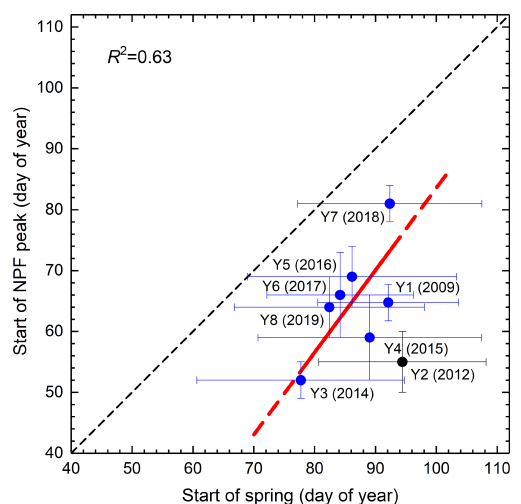
Figure 7. Scatter plot of the starting date of spring considering all vegetation and the start of the spring NPF occurrence season (peak). Labels for the measurement years Y1–Y8 and the calendar year of their spring (in parentheses) are also shown. The error bars indi- cate ± 1SD. The solid red line represents the linear fit, whereas its dashed parts were obtained by extrapolation. The data point for Y2 (2012), in black, represents a forested environment; therefore, it was excluded from the fitting. The coefficient of determination ( R 2 ) for the fit is also given. The line of equality is displayed in black for orientation